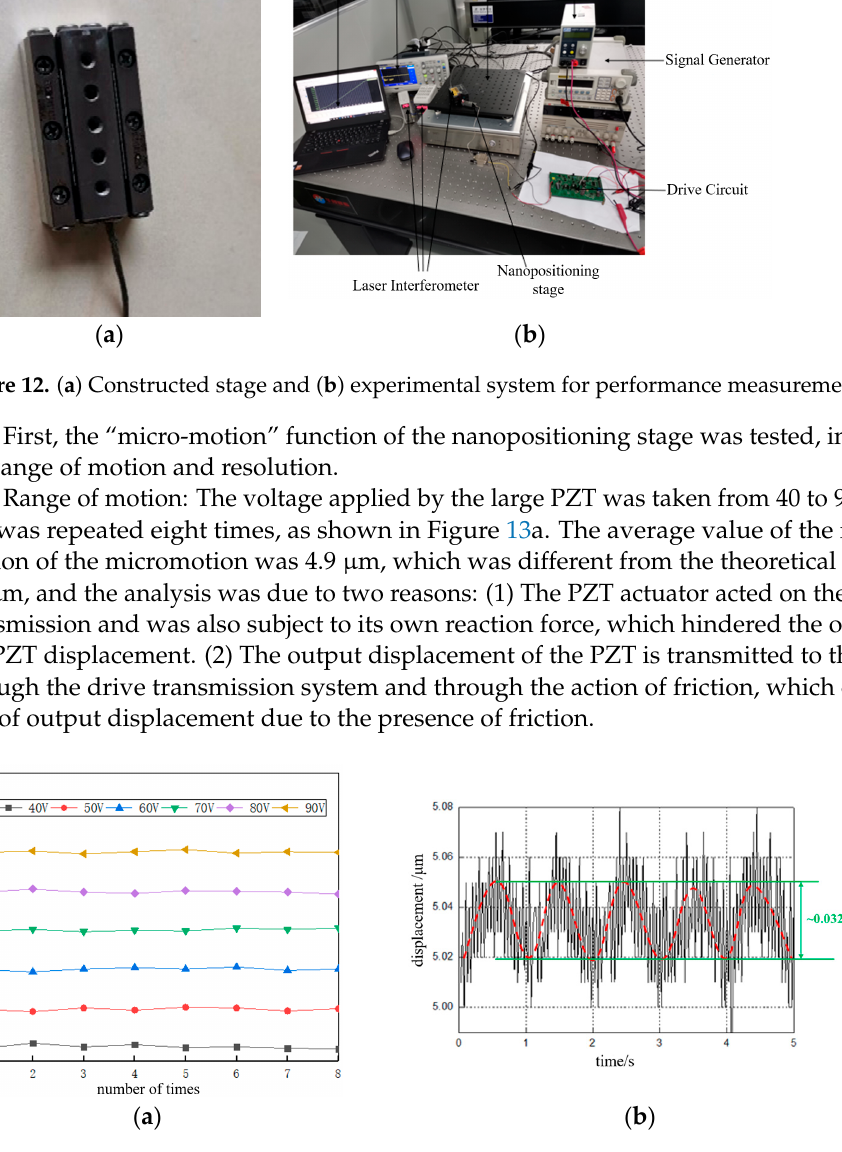
Figure 13. The results of the “micro-motion” function test. ( a ) Micro-motion state range-of-motion experimental results and ( b ) experimental results of micro-motion state motion resolution.